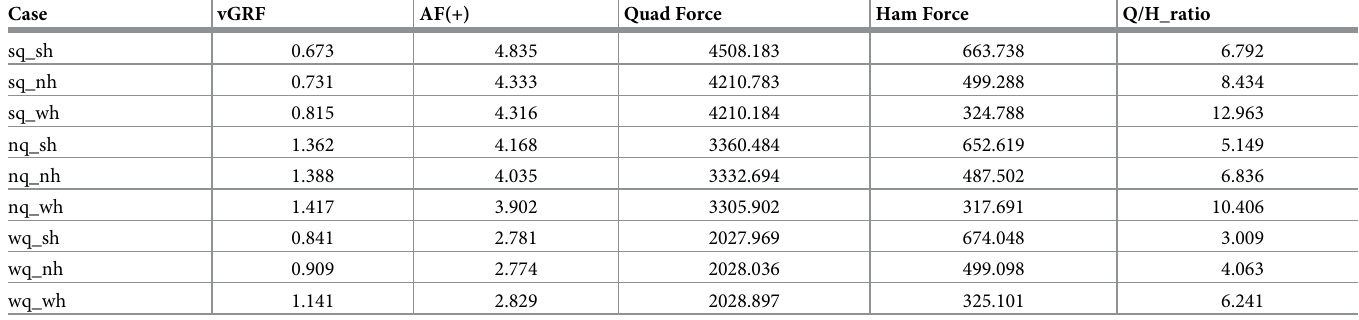
Table 10. Knee vGRF, AF, Quadricpes force, Hamstrings force and Q/H ratio at peak vGRF time instance for scenarios of normal, weak and strong knee joint ago- nist antagonist muscles.